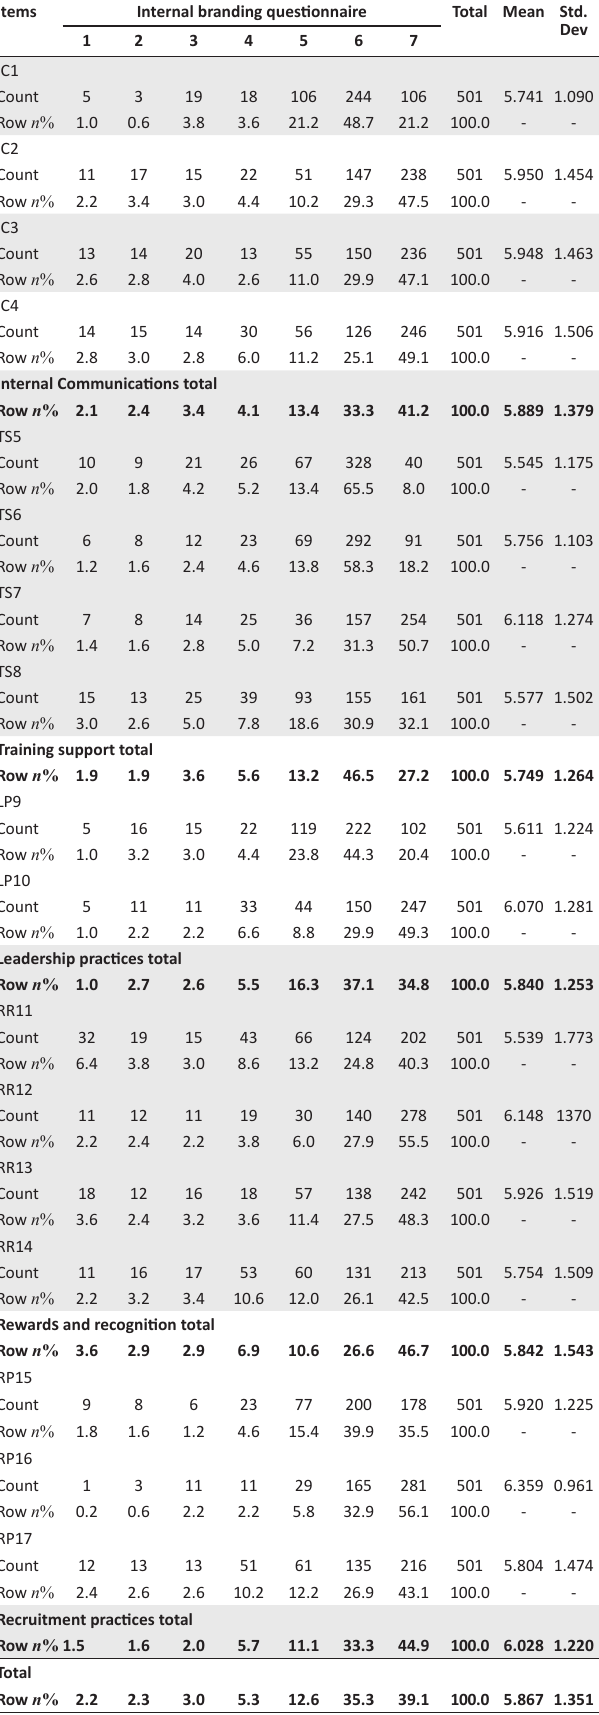
TABLE 3: Frequency distributions for the questionnaires used in the study. TABLE 3 (Continues…): Frequency distributions for the questionnaires used in